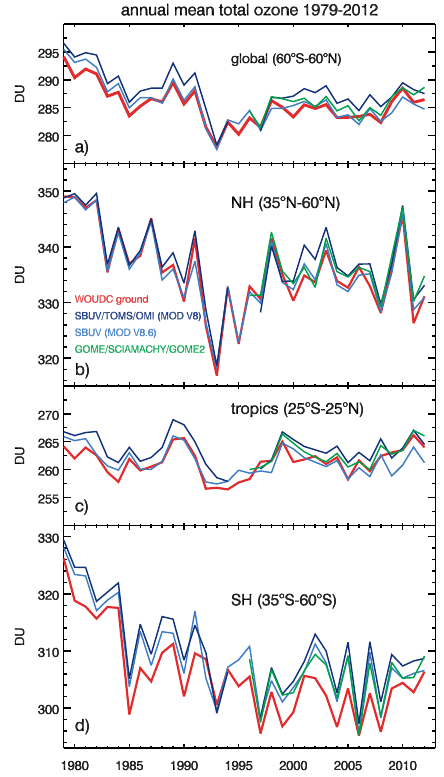
Figure 2. Annual mean area-weighted total ozone time se- ries of ground-based measurements combining Brewer, Dob- son, and filter spectrometer data (red, (Fioletov et al., 2002, 2008)), the merged SBUV/TOMS/OMI MOD V8.0 (dark blue: (Stolarski and Frith, 2006)), the merged SBUV/SBUV-2 MOD V8.6 (blue: DeLand et al. (2012); McPeters et al. (2013)), and GOME/SCIAMACHY/GOME-2 “GSG” (green, (Kiesewet- ter et al., 2010; Weber et al., 2011, 2013)), in the zonal bands: (a) 60 ◦ S–60 ◦ N (global), (b) 30–60 ◦ N (NH), (c) 25 ◦ S–25 ◦ N (tropics), and (d) 35–60 ◦ S (SH) zonal